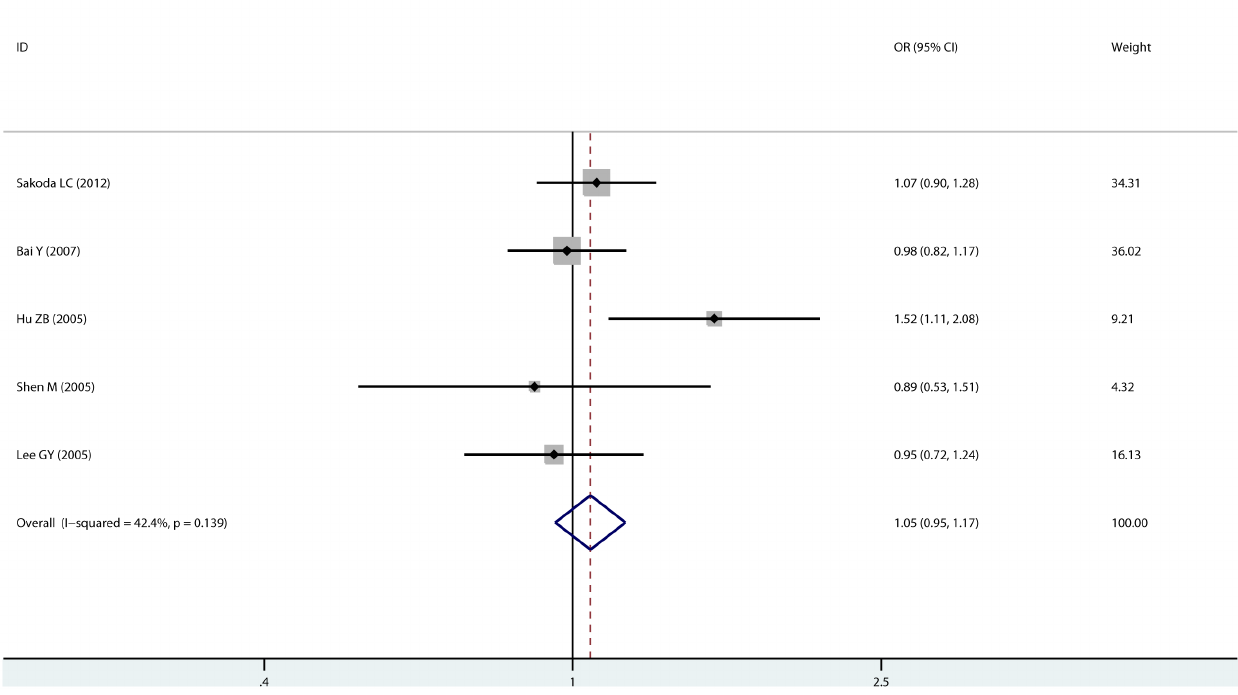
Figure 3. Forrest plot of XPC Ala499Val polymorphism (AlaVal/ValVal vs. AlaAla).